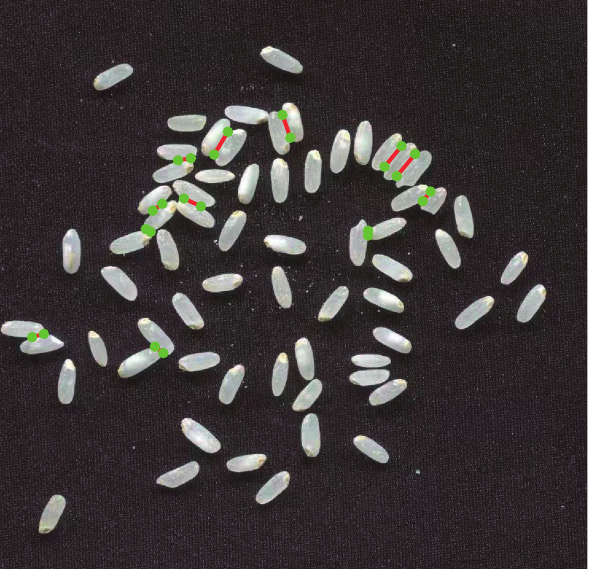
Figure 6. Segmentation